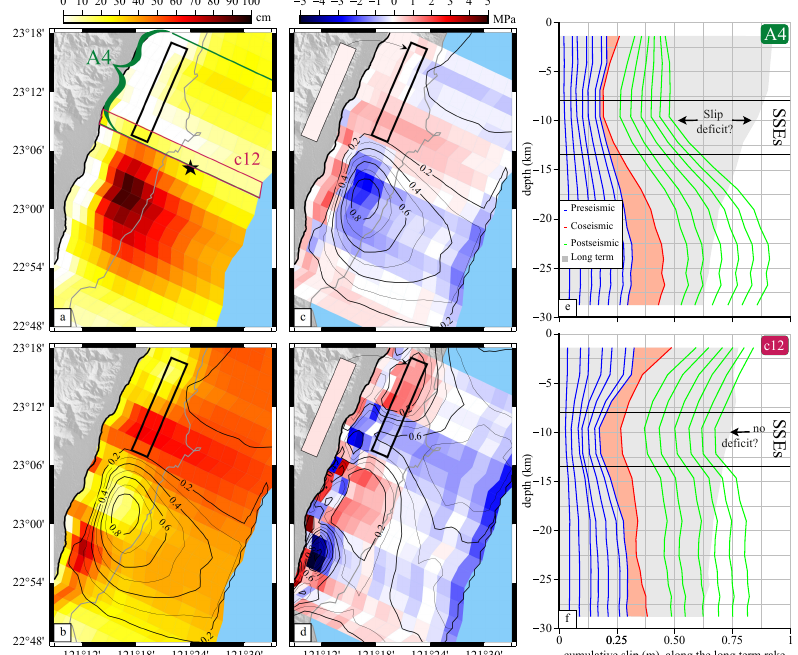
Figure 14. Kinematic slip models of ( a ) the 2003 Chengkung earthquake and ( b ) the following 7-year postseismic period and static Coulomb stress changes imparted by ( c ) coseismic and ( d ) postseismic slip, resolved onto the LVF fault plane. The plane depicted on the side represents Coulomb stress changes computed for a fixed rake of 70 ◦ . The black rectangle outlines the SSE rupture area and black star denotes the Chengkung earthquake epicenter, respectively. Black curves indicate contour lines of the coseismic ( b , c ) and postseismic ( d ) slip distribution models (in meter). Cumulative slip along the long-term rake for area A4 and c12 column (see ( a )) are given respectively in ( e , f ). Red and gray shading give respectively the coseismic slip and the total motion of the fault if it had crept at the long-term slip rate from 1997 to 2011. Figure adapted from Canitano et al. (2021)